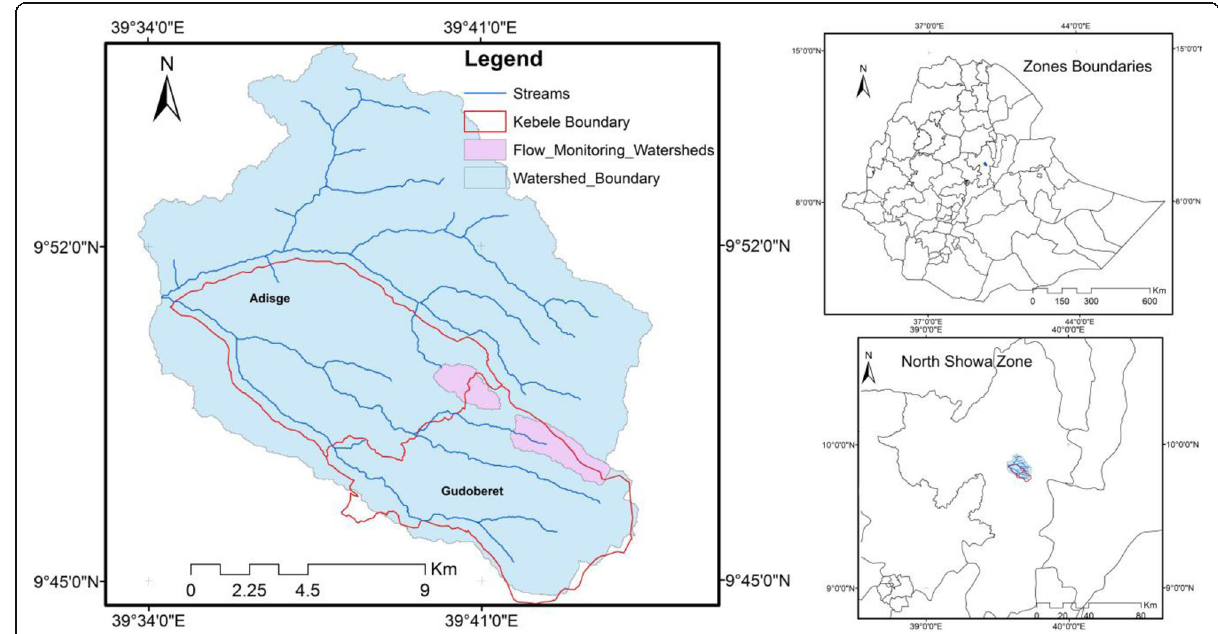
Fig. 1 Location map of the study